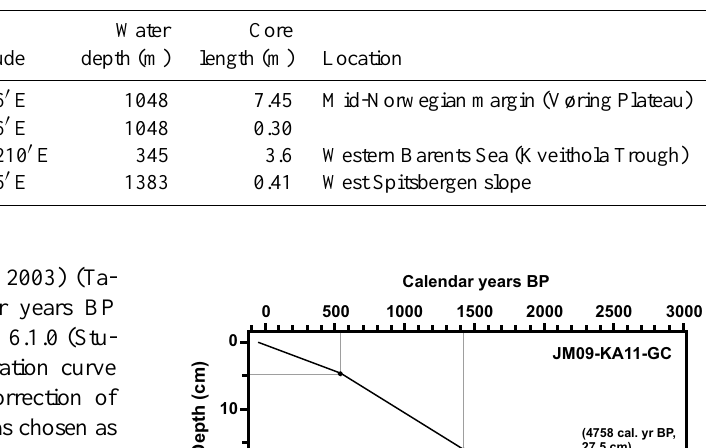
Table 1. Core location, water depth, length and geographical area.